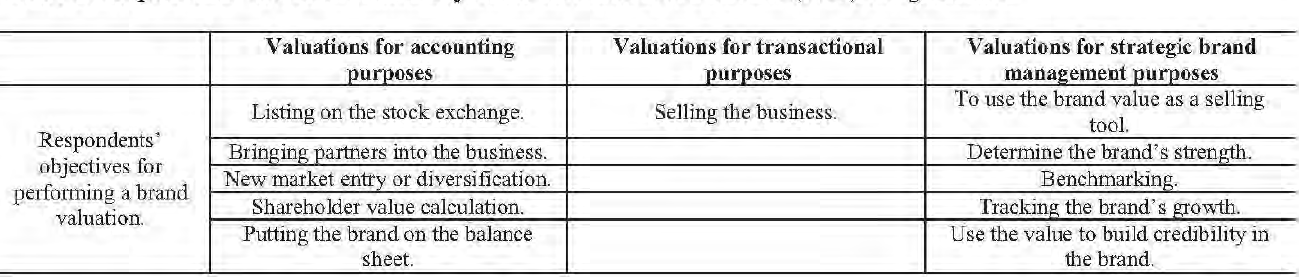
Table 2: Respondents' brand valuation objectives correlated with Salinas (2009) categorization Valuations for